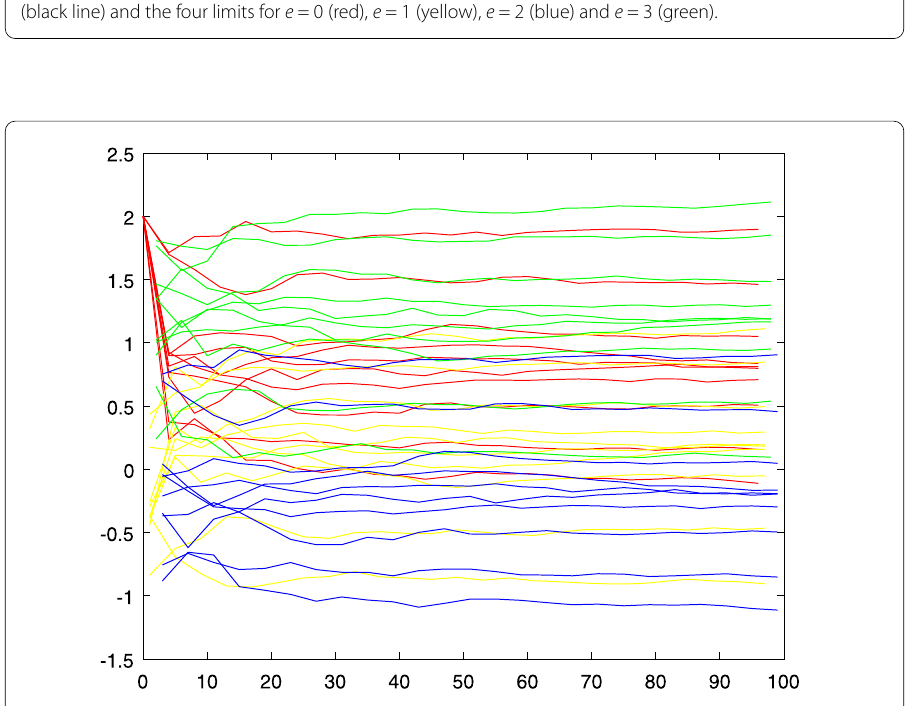
Figure 2 K = 2, a (0) = –1, a (1) = 1, ˆ g = 1. A set of ten sample trajectories, showing the four random limits for e = 0 (red), e = 1 (yellow), e = 2 (blue) and e = 3 (green).